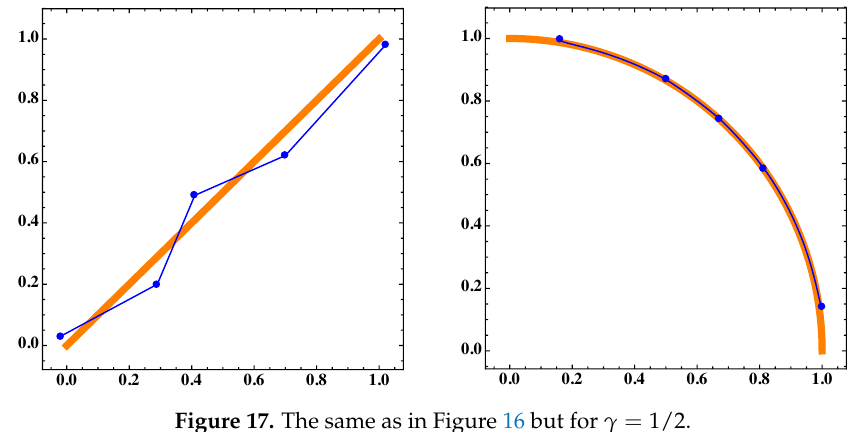
Figure 17. The same as in Figure 16 but for γ = 1/2. Table 5. ∆ p , q results for the approximations of the Pareto set and front for MOP (Equation (16)). Decision Space Objective Space p q Finite Arch. Cont. Arch. Finite Arch. Cont. Arch.